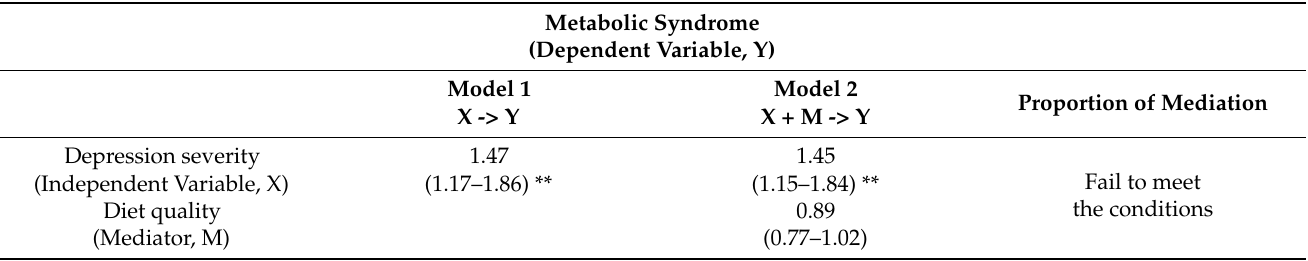
Table 9. The mediating effect of diet quality on the association between depression severity and metabolic syndrome.